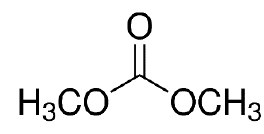
Figure 4. Structural formula of DMC.